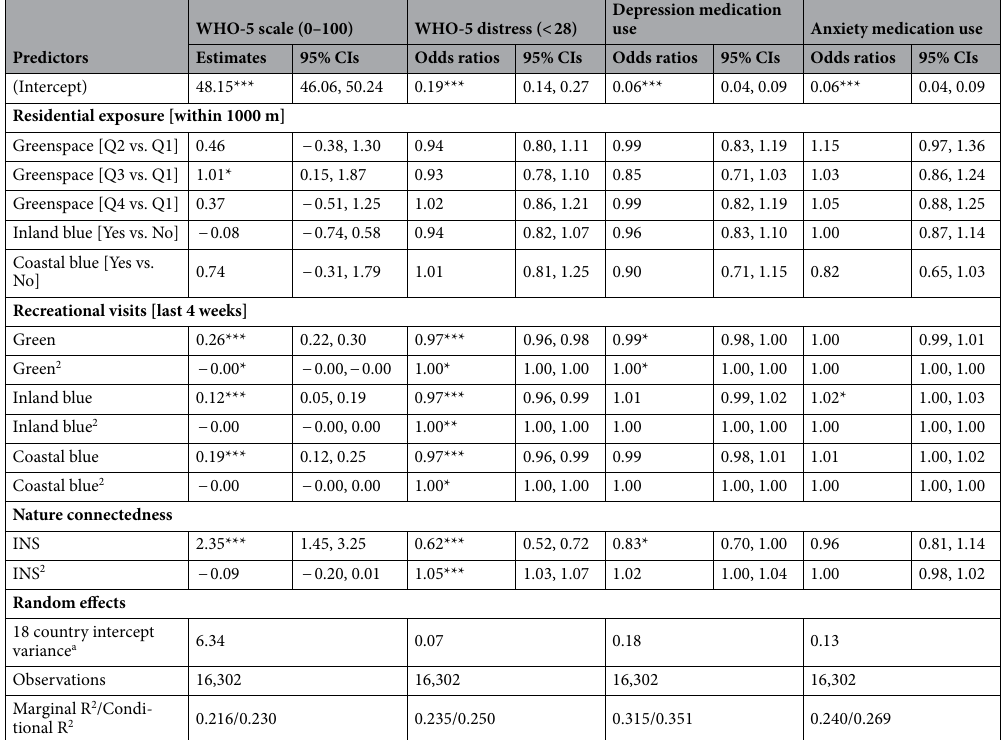
Table 2. Mental health as a function of residential exposure, recreational visits and nature connectedness controlling for socio-demographics, season and country. Analyses used survey weights. INS inclusion of nature in self scale. a Variance of country-level intercepts from the random effects component of the model; Marginal R 2 includes only fixed effects and Conditional R 2 includes the random country effect, R 2 for binary outcomes = Nakawaga Pseudo R 2 . Models control for sex, age, household income, employment status, education, long-term illness/disability, marital status, number of adults and children in household, dog and car ownership, weekly physical activity, season of data collection, and use of the alternative depression/anxiety medication for medication models only; full models in Supplementary Tables S2 and S3. * p < 0.05, ** p < 0.01, *** p <